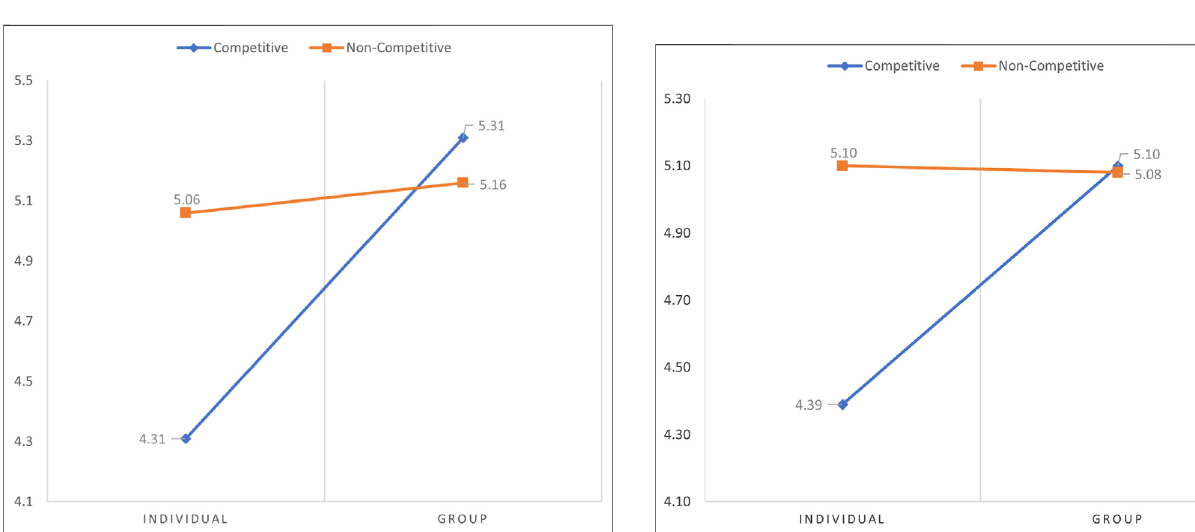
FIGURE3| Interactioneffectsofcompetitivenessandlearningformaton Goal Clarity.